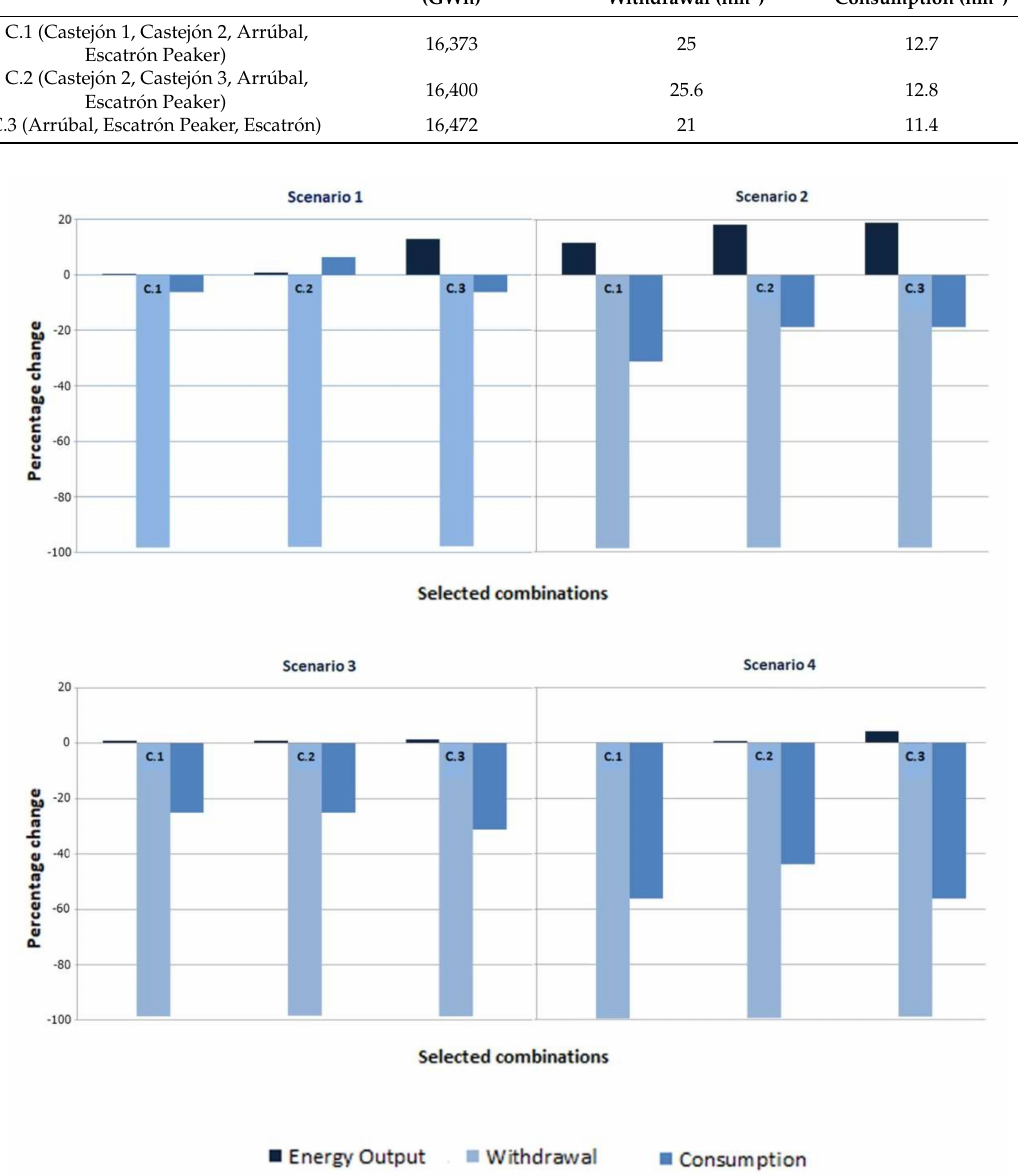
Figure 6. Summary of scenarios compared to the baseline. Note: the maximum output, water withdrawals, and water consumption attainable by nuclear power plants represent the baseline. Values above zero show increases in energy output or water use compared to the baseline. Values below zero show water savings compared to the baseline. Source: own